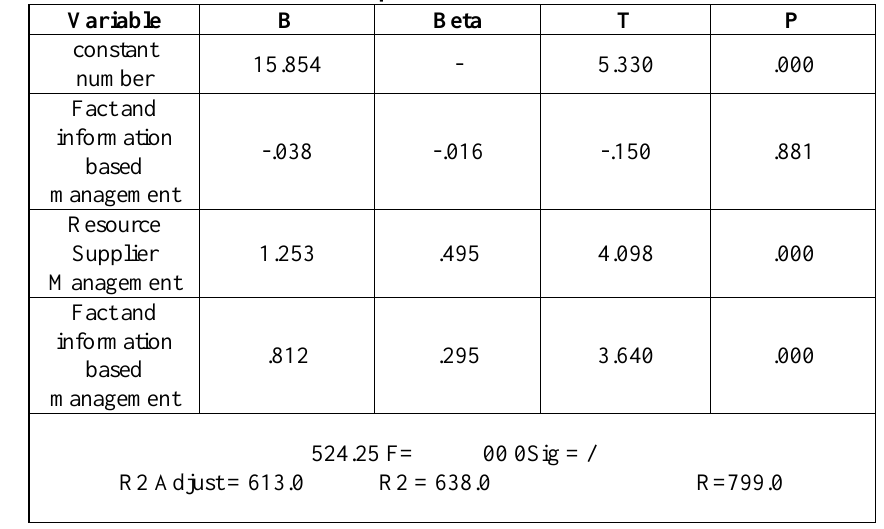
Table 5. Results of multiple regression analysis for all dimensions of